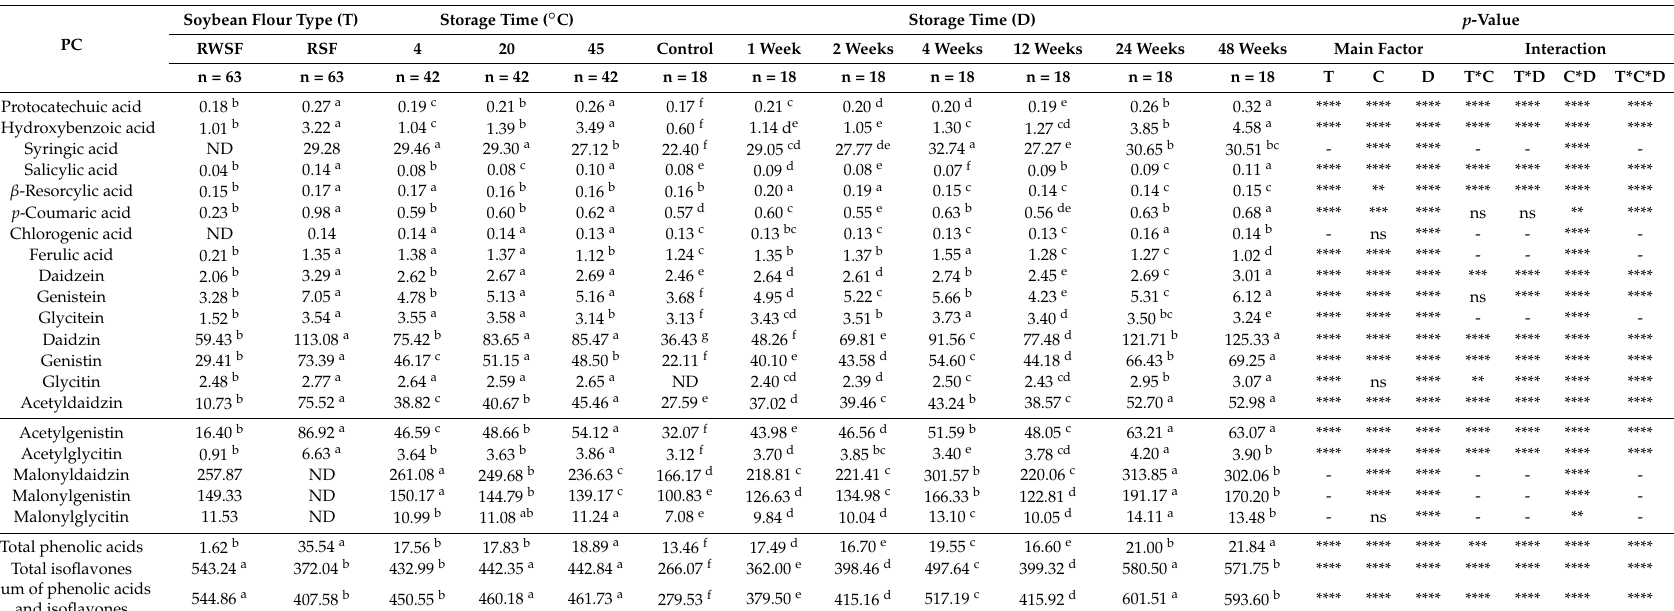
Table 4. Comparison of PC composition and content ( µ g/g on dry weight basis) depending on soybean flour type, storage condition, and duration and the associated GLM p -value for main factor and its